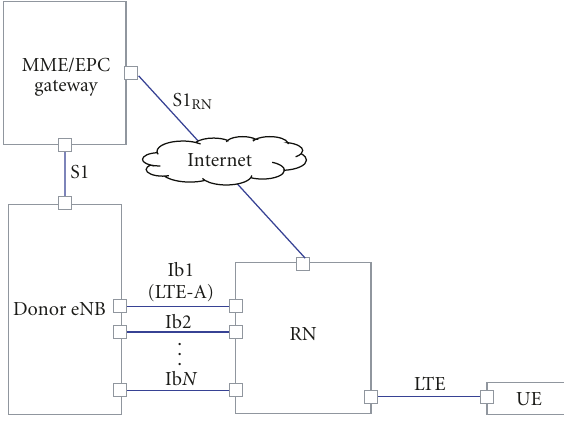
Figure 6: A multimode RN enhanced with home eNB